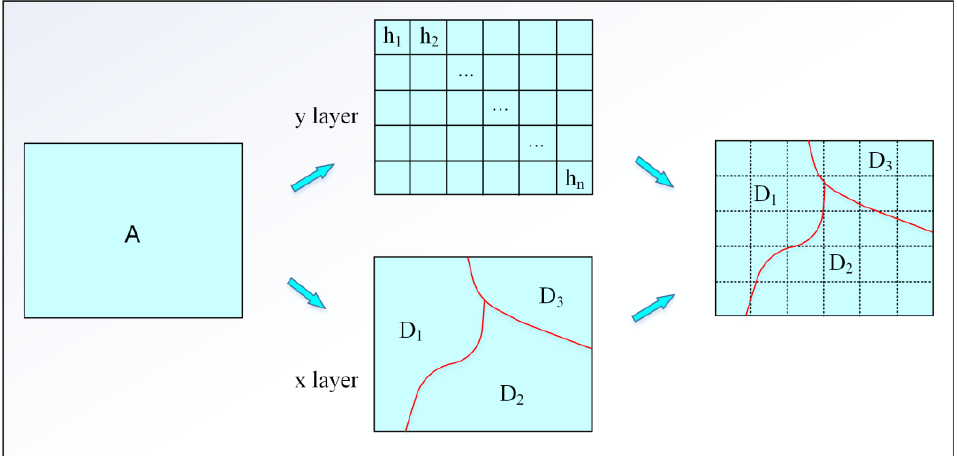
Figure 2. Illustration of the principle of the GeoDetector model. The study area A, the grid system H = {h i , i = 1, 2, … , n}, and the sub-region of the potential factor D = {D i , i = 1, 2,